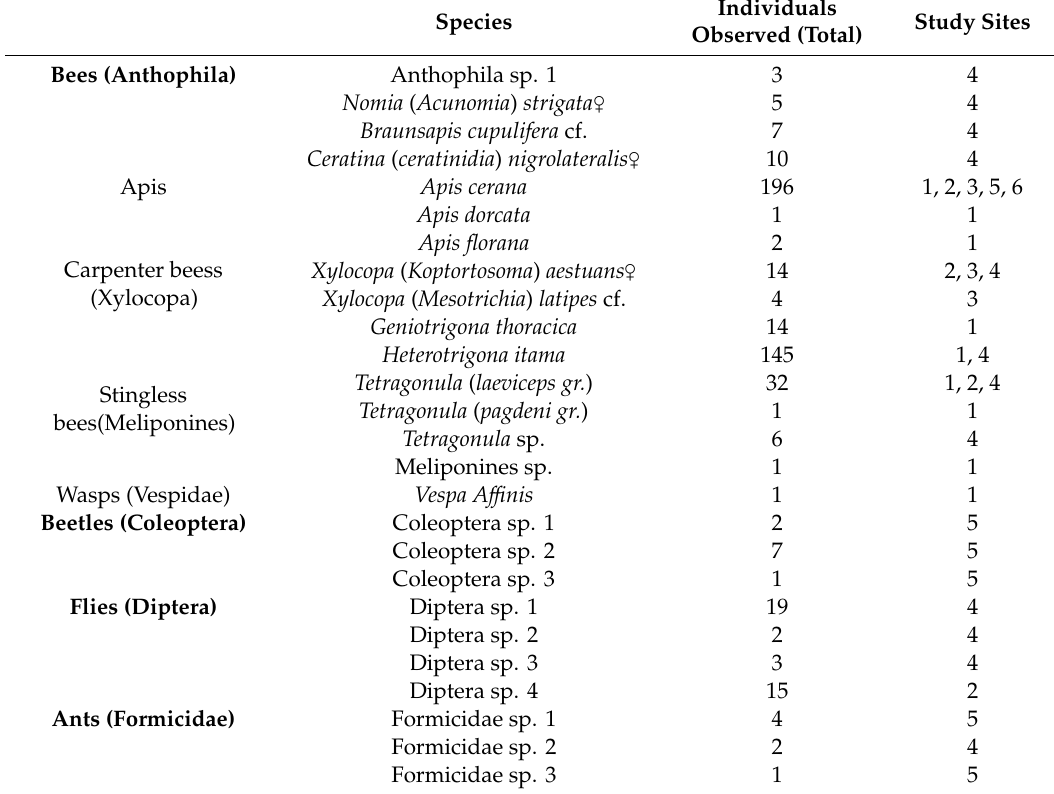
Table A1. Complete list of all species observed in the six guava orchards. Identified down to lowest possible taxonomic